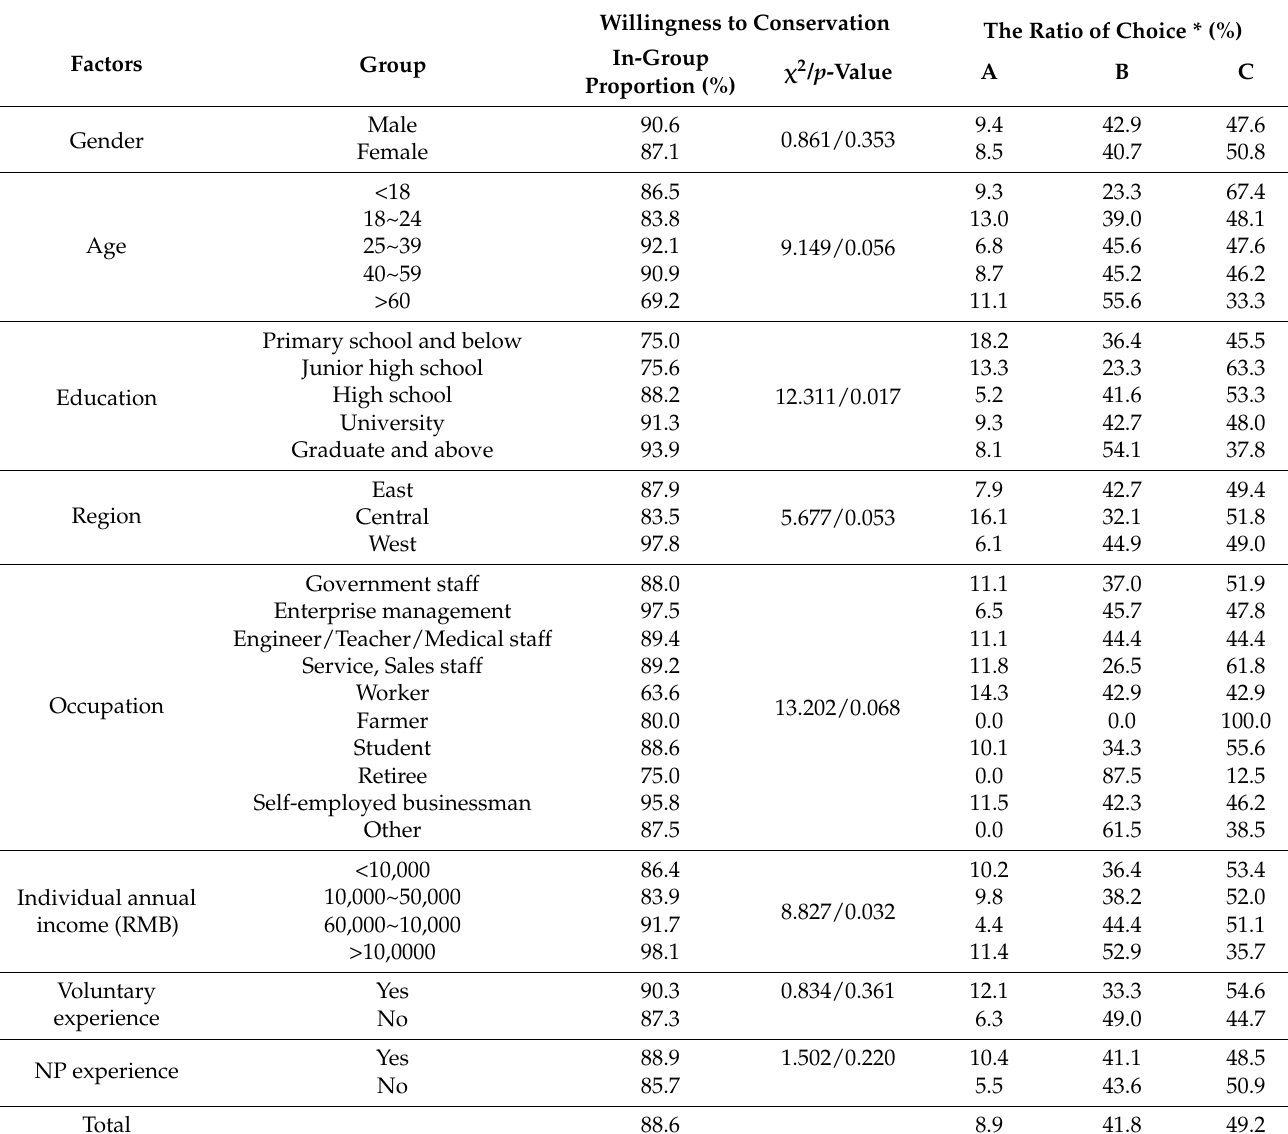
Table 5. Conservation willingness and forms based on demographic